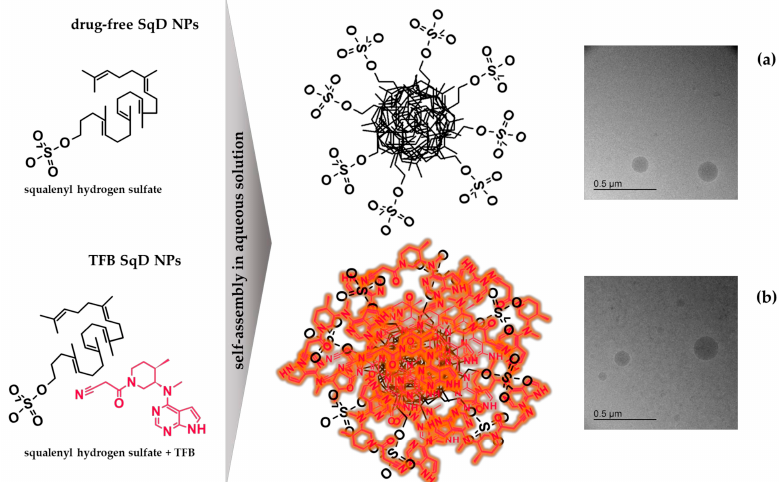
Figure 1. Schematic illustration of SqD and TFB chemical structures, and the self-assembled drug-free SqD NPs and TFB SqD NPs. Morphology of ( a ) drug-free SqD NPs and ( b ) TFB SqD NPs visualized by cryo-TEM. Black scale bar equals 0.5 μ m.